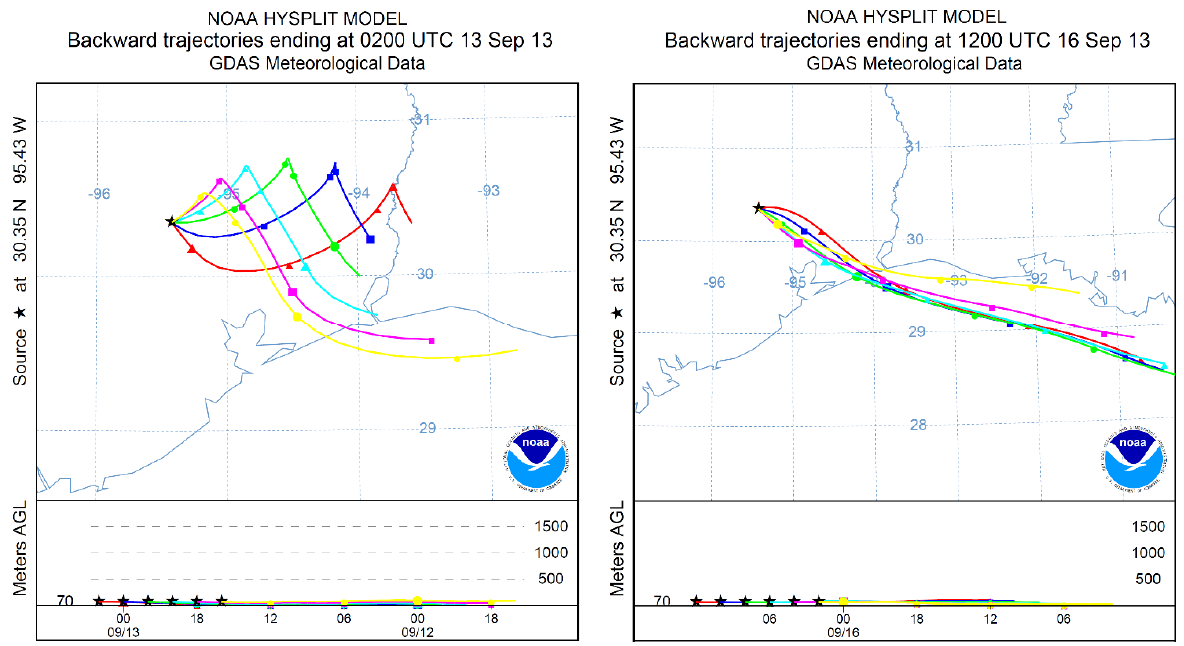
Figure 5. A comparison of HYSPLIT back trajectories for the days shown in the insets of Figure 2. Left: Back trajectories for the morning of 13 September 2013. The back trajectories ending at the time of peak ClNO 2 concentrations (10–11 p.m.) show air that originated inland near the TX-LA border 24 hours prior. Right: Back trajectories for the morning of 16 September 2013. The back trajectory at the time of peak ClNO 2 concentration (7–8 a.m.) indicates that the air mass originated in the Gulf of Mexico 24 hours prior, passing between the Houston, TX region and the LA-TX